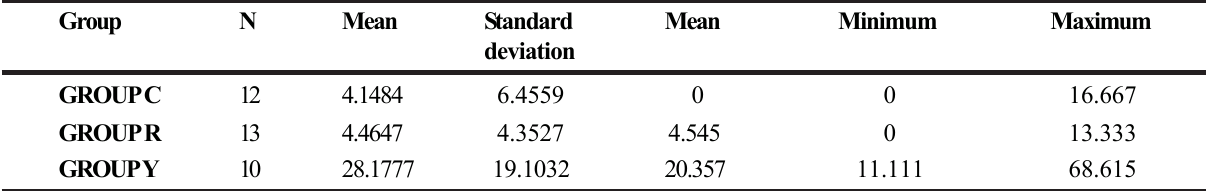
FIGURE 2 - Dispersion of steatocrit measures in each TABLE 1 - Measures of position and dispersion for steatocrit in each group